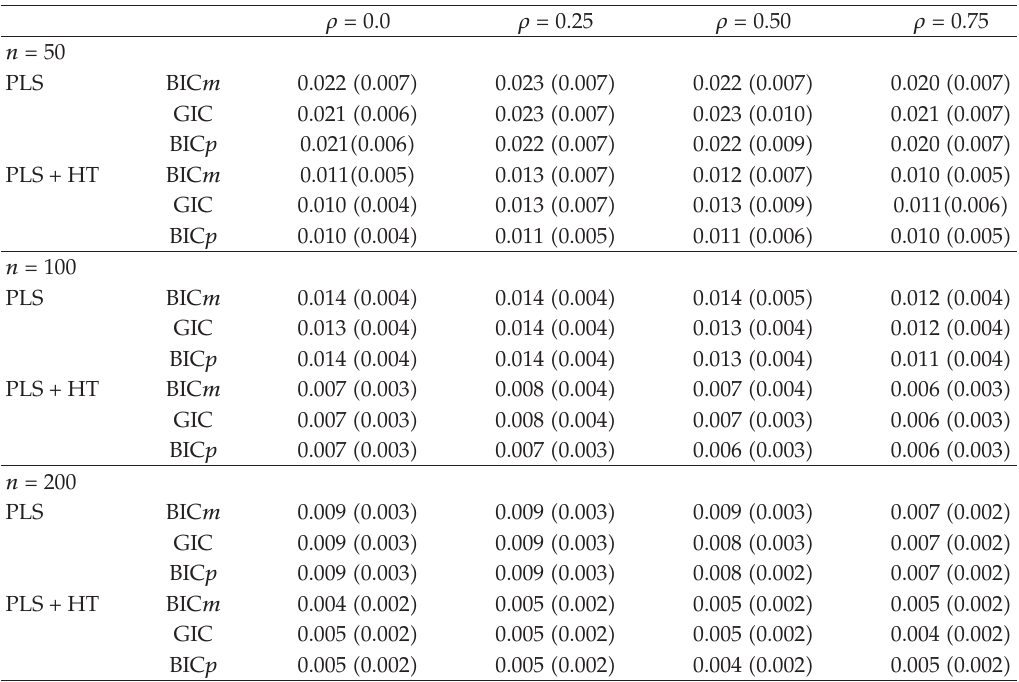
Table 2: Means (cid:3) standard deviations (cid:6) of RASE β . ρ (cid:7) 0 .